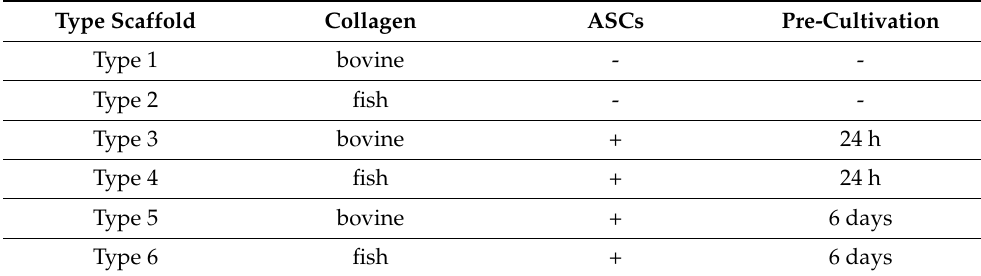
Table 1. The types scaffolds. Type Scaffold Collagen